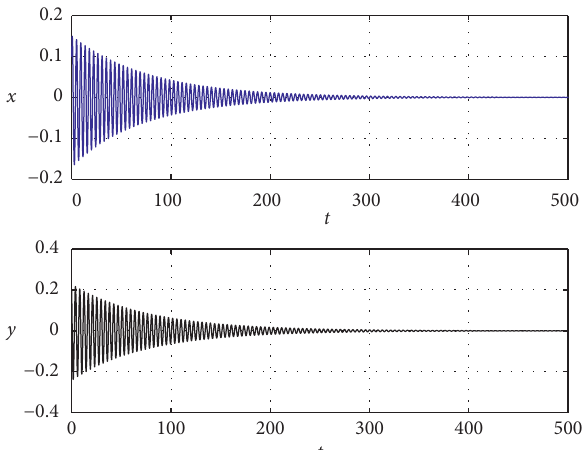
Figure 2: Waveform plot of system (7) near ( d tspan � [ 0 , 500 ] , and ( x